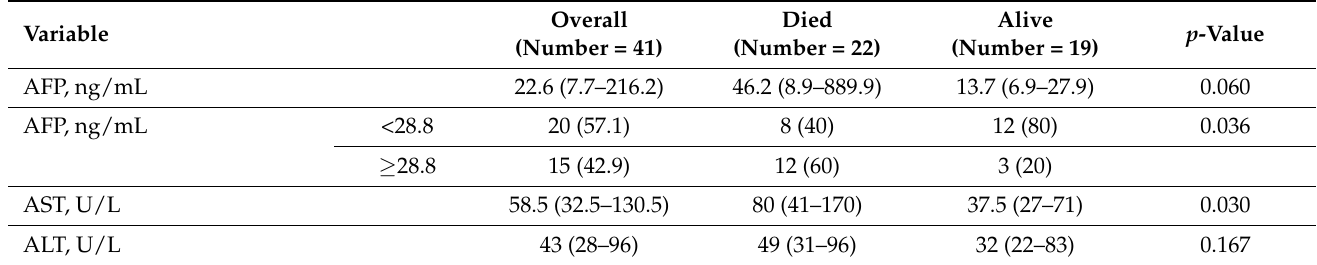
Table 2. Biochemistry of PLWH at invasive therapy for HCC according to the primary study outcome (died or